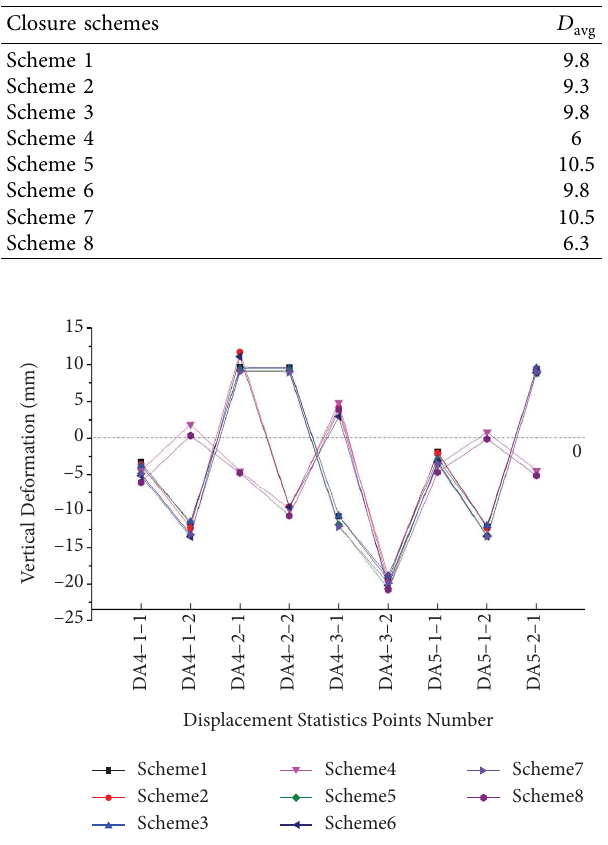
Figure 12: Deviation of the displacement statistical